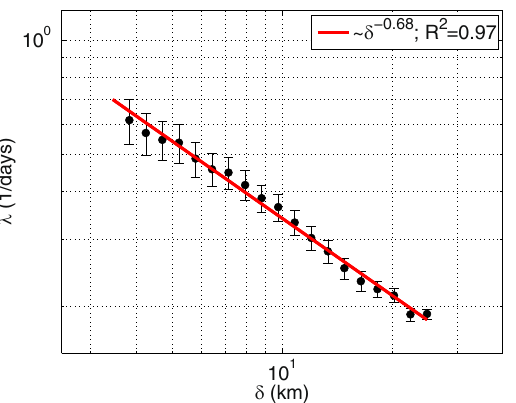
Figure 2. FSLE curve ( λ ( δ )) at different spatial scales δ using velocity data from HF Radar averaged over a total of 480 samples homogeneously distributed from July 2012 to June 2014. The legend shows the value of the slope and the correlation coefficient obtained from the best fitting analysis. The figure was made using MATLAB R2012a